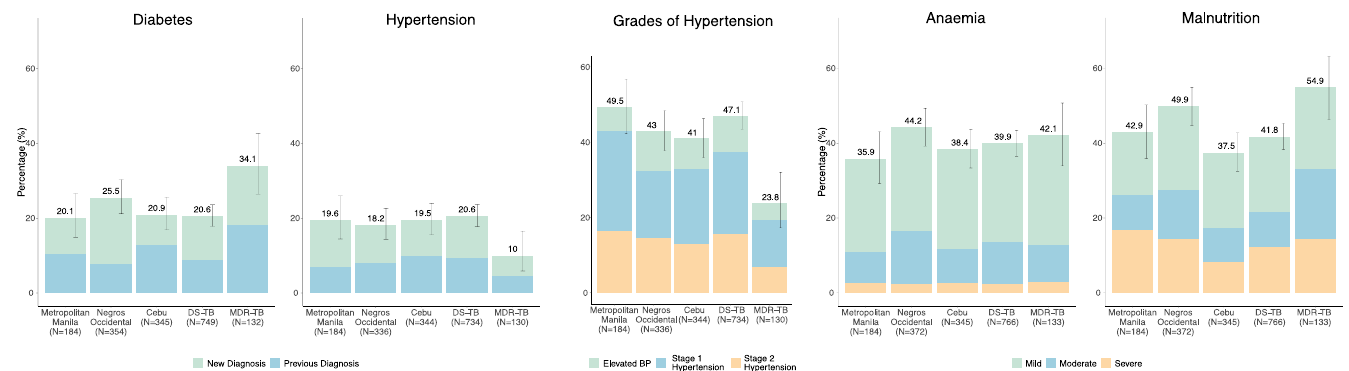
Fig 3. A . Prevalence, severity and existing and new diagnoses of diabetes and hypertension comorbidities by region and by drug sensitive or multi-drug resistant TB treatment regimen. Diabetes: HbA1c 6.5% or currently taking recognised diabetes medication. Previous diagnosis = reported diagnosis prior to TB diagnosis. Prevalence of diabetes did not differ by region (chi2 p = 0.24) but was higher in MDR vs DS TB treatment (chi2, p = 0.001). The proportion of new vs . previous diabetes diagnoses differed significantly by region (chi2, p < 0.001) but not by MDR vs DS TB treatment regimen (chi2, p-0.21). Hypertension: defined as stage 2 hypertension: Systolic BP > 140 mmHg OR diastolic BP > 90 mmHg or currently taking recognised anti-hypertensive medication. Previous diagnosis = reported diagnosis prior to TB diagnosis. The prevalence of hypertension did not differ significantly by region (chi2, p = 0.91) but was lower in MDR vs DS TB treatment (chi2, p = 0.005). The proportion of new vs previous hypertension diagnoses did not differ by region or MDR vs DS TB treatment regimen (chi2, p = 0.741; p = 0.280). Grades of Hypertension: Elevated BP = elevated systolic BP � 120 mmHg < 130 mmHg & normal diastolic BP < 80 mmHg; Stage 1 Hypertension = systolic BP � 130 mmHg < 140 mmHg OR diastolic BP � 80 mmHg < 90 mmHg; Stage 2 hypertension: Systolic BP > 140 mmHg or diastolic BP > 90 mmHg. The prevalence of elevated BP/hypertension (all grades combined) did not differ significantly by region (chi2, p = 0.170) but did by MDR vs DS TB treatment regimen (chi2, p < 0.001). The relative proportion of grades of hypertension (elevated, stage 1, stage 2) did not differ by region or MDR vs DS TB treatment regimen (chi2, p = 0.19, p = 0.84). B. Prevalence and severity of malnutrition and anaemia comorbidities by region and by drug sensitive or multi-drug resistant TB treatment regimen. Footnotes: Undernutrition: Mild = Body Mass Index (BMI) < 18.5–17 kg/m2; Moderate = BMI < 17–16 kg/m2; Severe = BMI < 16 kg/m2. The prevalence of all grades of undernutrition differed significantly by region (chi2, p = 0.004) and by MDR vs DS TB treatment regimen (chi2, p = 0.005). The relative proportions of grade of undernutrition did not differ by region (chi2, p = 0.085) or by MDR vs DS TB treatment regimen (chi2, p = 0.12). Anaemia: Mild = Haemoglobin (Hb) < 13.0 [male] < 12.0 [female] g/dl— > 11.0 g/dl; Moderate Hb � 11.0–8.0 g/dl; Severe Hb < 8.0 g/dl. The prevalence of all grades of anaemia did not vary significantly by region or by MDR vs DS TB treatment regimen (chi2, p = 0.49 & p =